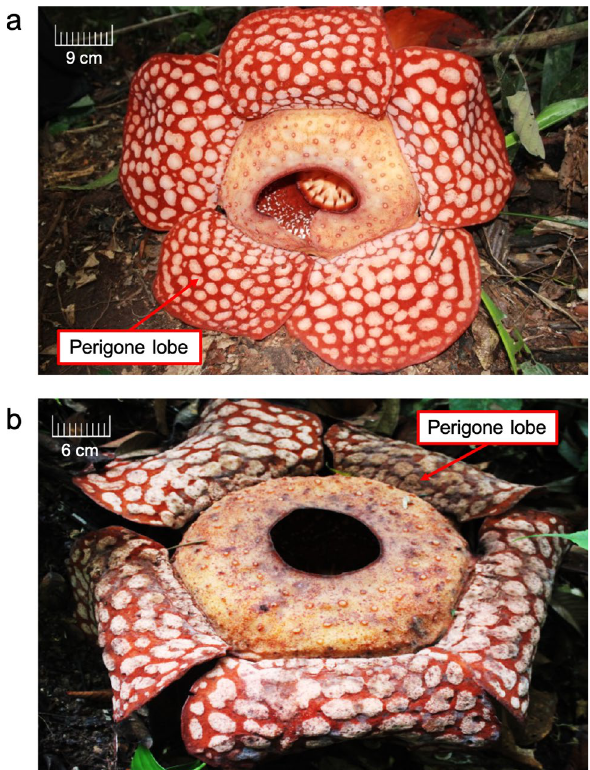
Figure 1. The Rafflesia cantleyi flowers. R. cantleyi samples ( a ) one day (F1) and ( b ) three days (F2) after blooming were collected from Bukit Lahar, Pahang, Malaysia. Tissue samples from the perigone lobes of the two different flowers were obtained for transcriptome sequencing.